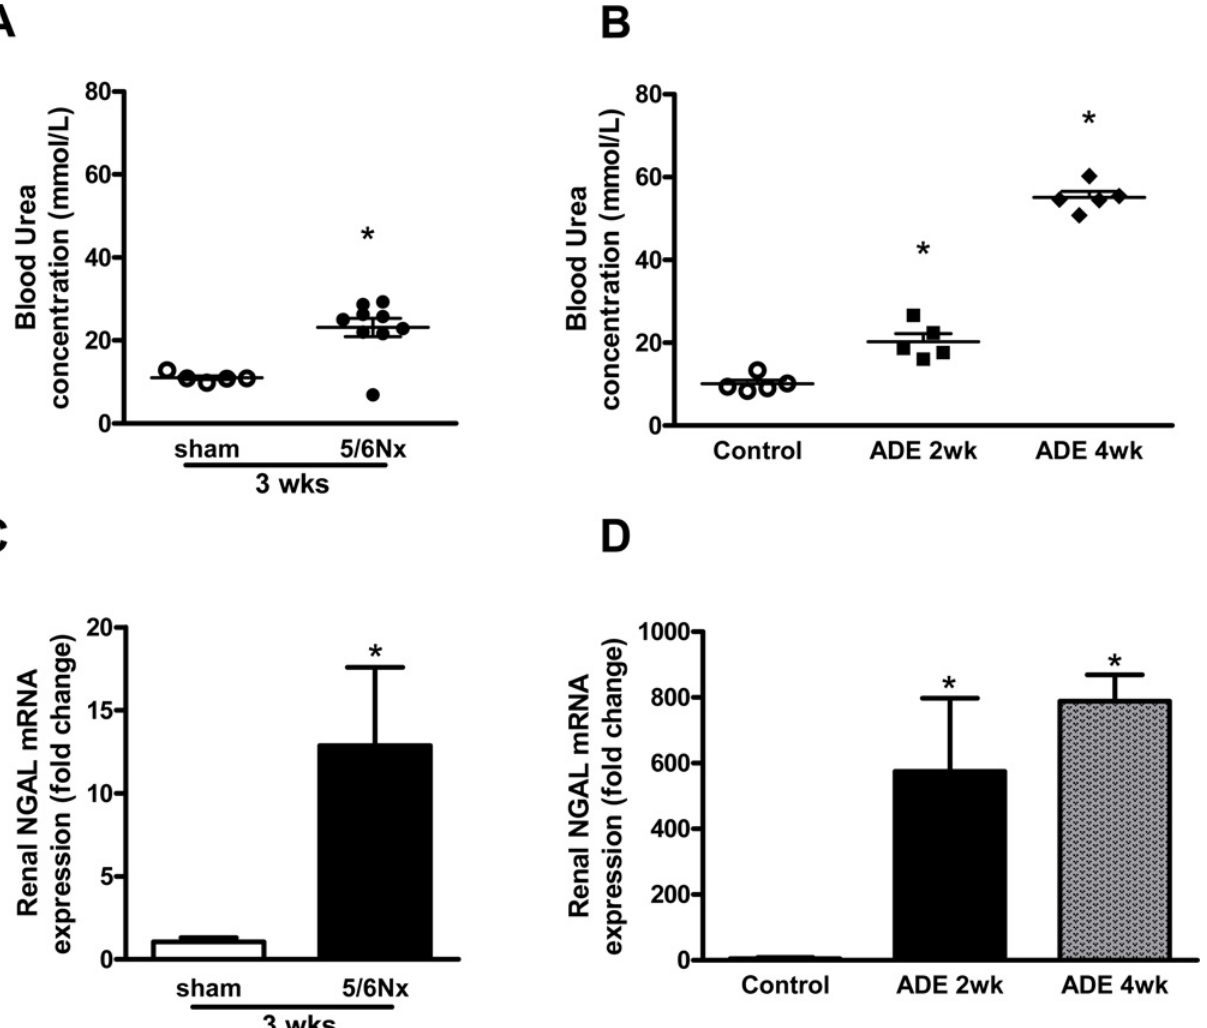
Fig 1. Partial nephrectomy and adenine-enriched dietary treatment induced CKD. Mice subjected to (A) partial nephrectomy (5/6Nx; n = 9) after 3 weeks and (B) adenine-enriched dietary treatment (ADE; n = 5) for either 2 or 4 weeks display elevated blood urea levels, when compared to sham-operated (n = 5) or control mice (n = 5), respectively. Renal expression of tubular injury marker NGAL is significantly elevated in (C) 5/6Nx mice and (D) ADE mice after 2 and 4 weeks, compared to sham-operated or control mice, respectively. Data are mean ± SEM. * : p < 0.05 compared to either sham-operated or control